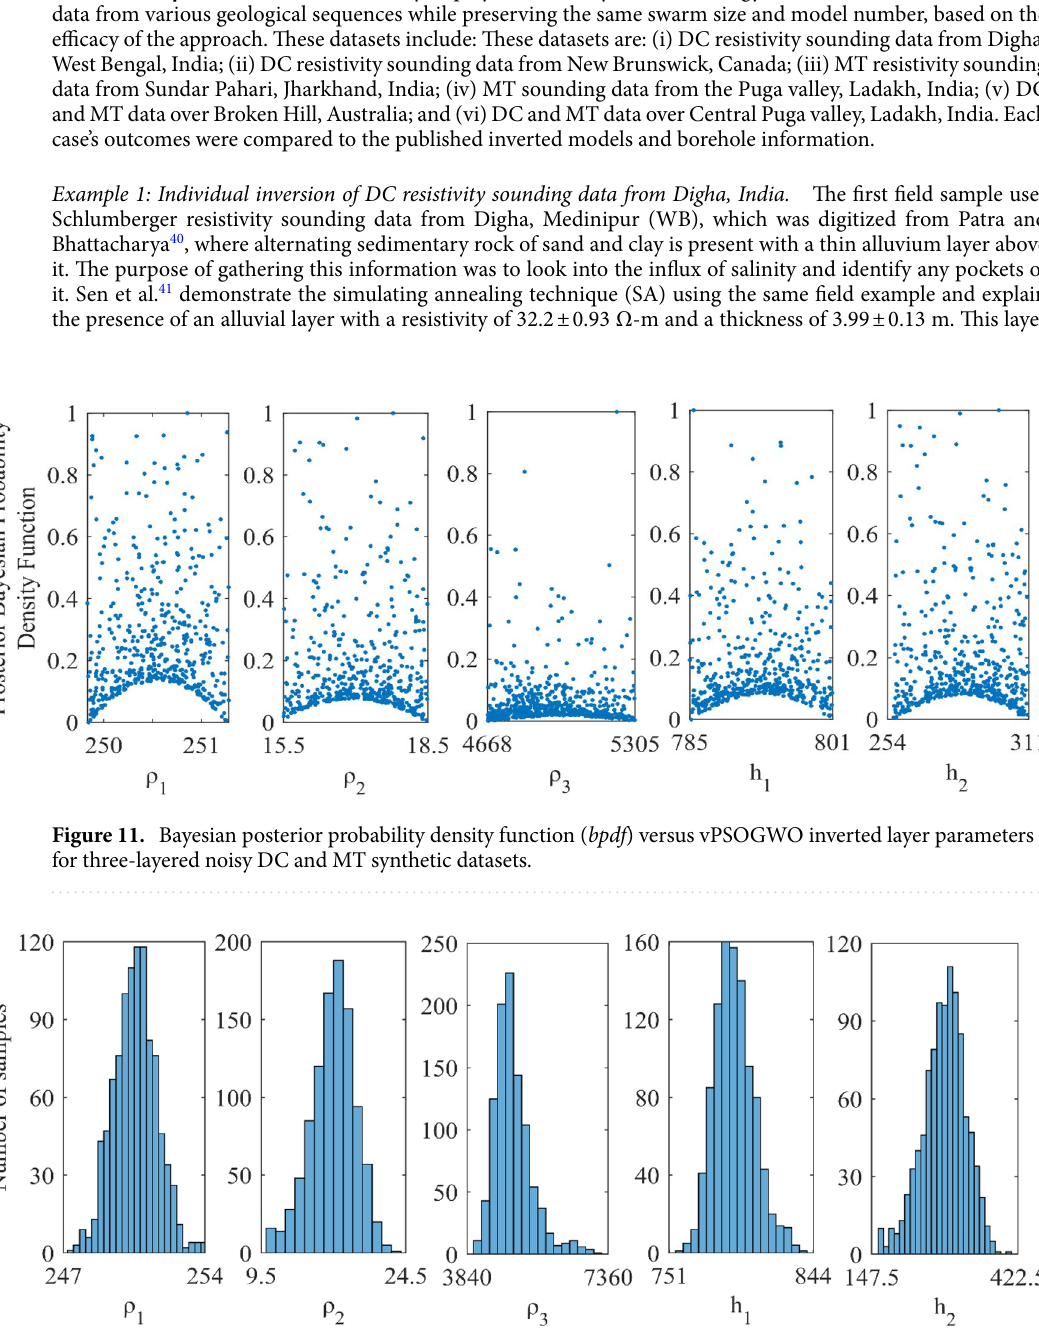
Figure 12. A number of samples versus vPSOGWO inverted layer parameters for three-layered noisy DC and MT synthetic